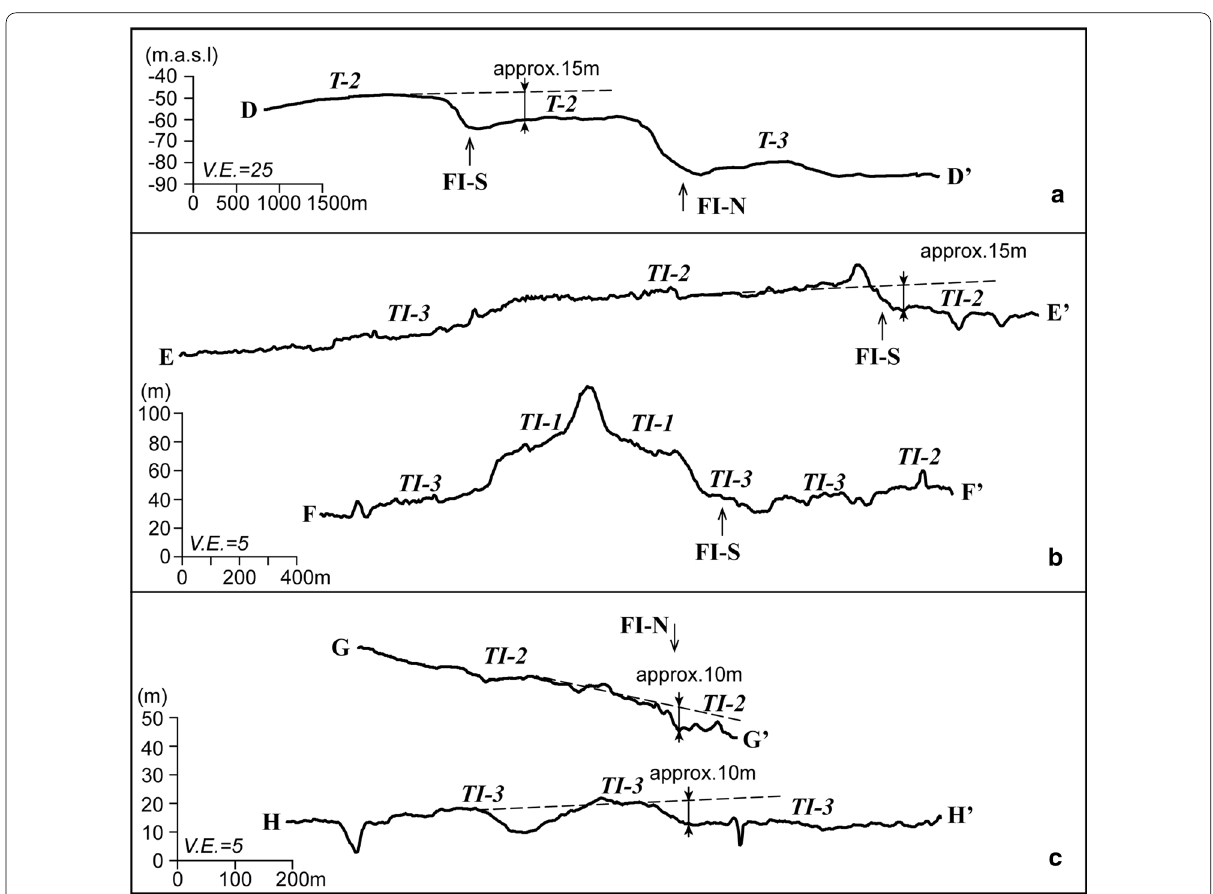
Fig. 5 Topographic profiles across the Izenajima fault zone. a Profile based on the DEM shown in Fig. 1C. b , c Profile based on the onshore DSM processed in this study. The locations of these profiles are shown in Figs. 2 and